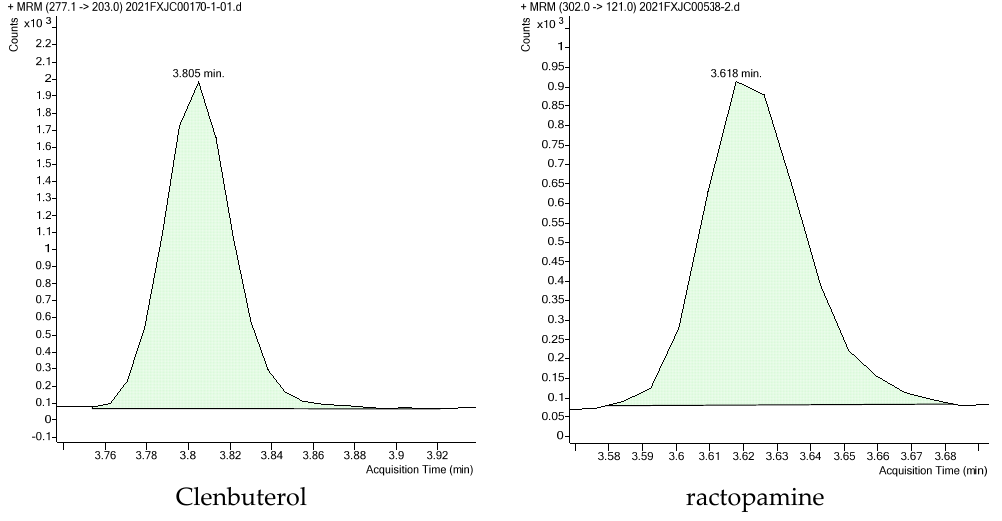
Figure 4. Extracted ion chromatogram (EIC) of clenbuterol and ractopamine in two actual